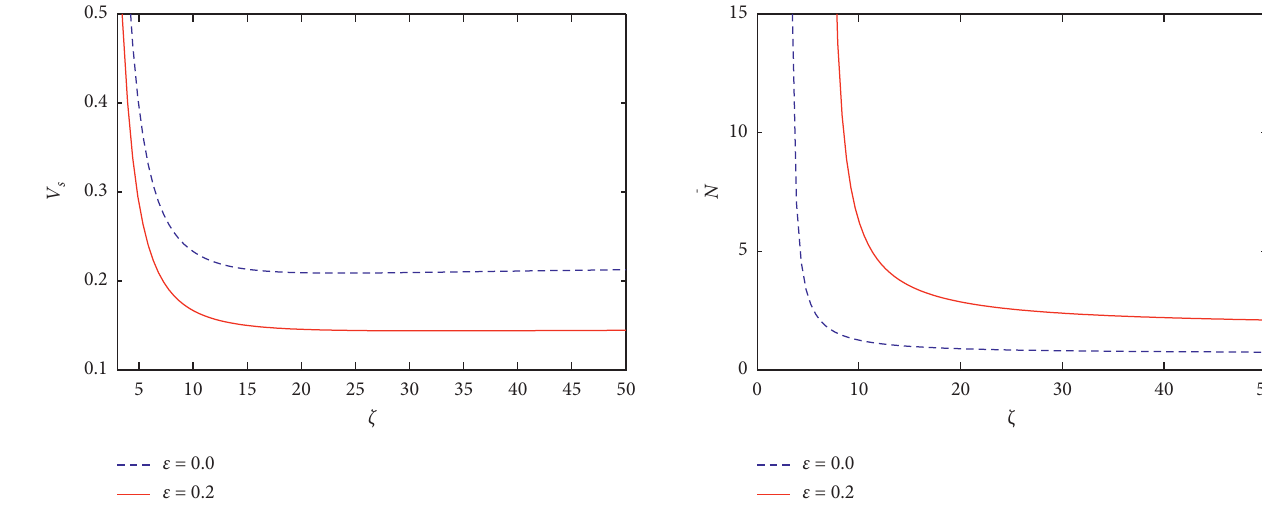
Figure 4: Plots of V Figure 6: Plots of the steady state mean photon number (equation � 0 . 8, r � 0 . 75, s (equation (26)) versus for κ and A � 2 . 5 and for different values of ε . (57)) versus ζ for κ � 0 . 8, r � 0 . 75, and A � 2 . 50 and for different values of ε .